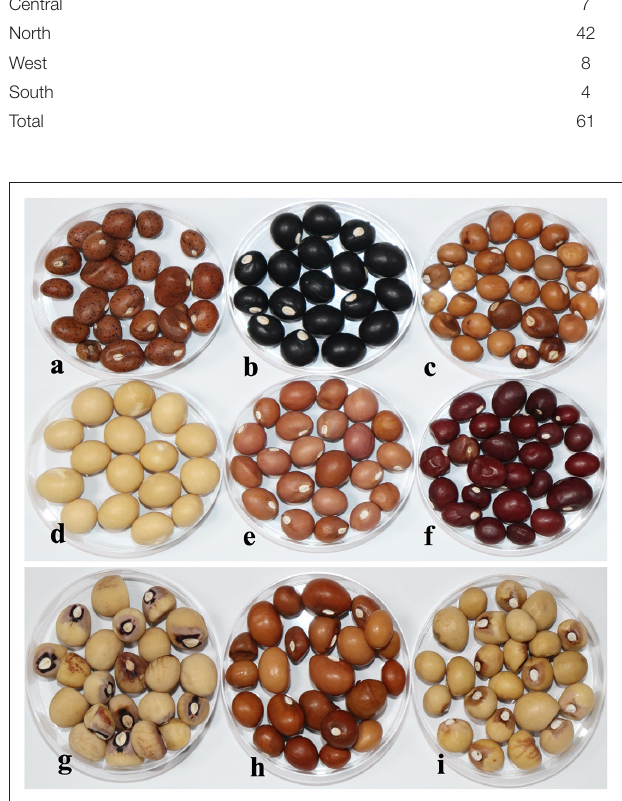
FIGURE 5 | Genetic varaition of seed triats in Bambara groundnut landraces for seed color (a) TVSu-1749 others type, (b) TVSu-1918 black, (c) TVSu-1574 tan brown, (d) TVSu-1981 cream, (e) TVSu-1399 light brownish red, (f) TVSu-2032 dark red and seed shape type (g) TVSu-1412 round type, (h) TVSu-2014 other type, (i) TVSu-1397 oval